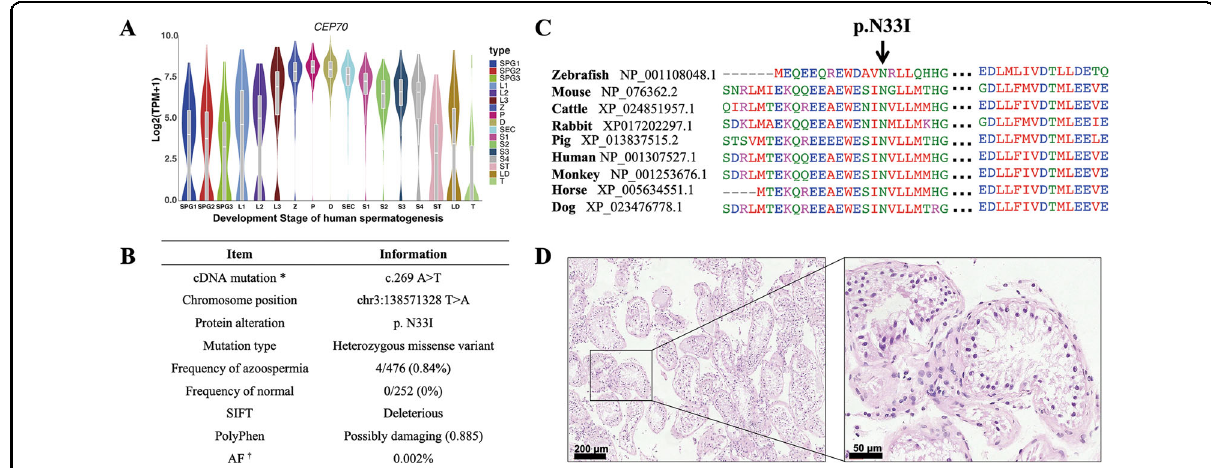
Fig. 1 The expression pattern of CEP70 during human spermatogenesis and clinical mutation screening. A The mRNA expression pattern of CEP70 during human spermatogenesis. SPG1: spermatogonial stem cells; SPG2: differentiating spermatogonia; SPG3: differentiated spermatogonia; L1-L3: three consecutive stages of leptotene spermatocytes; Z: zygotene; P: pachytene; D: diplotene; SEC: a mixture of diakinesis, metaphase, anaphase, telophase and secondary spermatocytes; S1 – S4: four stages of spermatids; ST: Sertoli cell; LD: peritubular myoid cells (PMCs) and Leydig cells; T: testicular macrophages. B Analysis of CEP70 mutation in azoospermia patients. *: the accession number for CEP70 is GenBank: NM_024491.4; † : frequency of existing variant in 1000 Genomes combined population. C Homology analysis of amino acid changes caused by mutation sites among different species. D H&E staining of clinicopathological sections of azoospermia patients with the same heterozygous